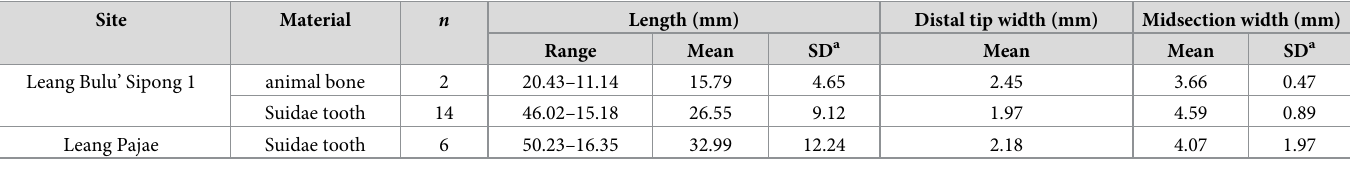
Table 3. Metrics for the osseous points of Leang Bulu’ Sipong 1 and Leang Pajae. Site